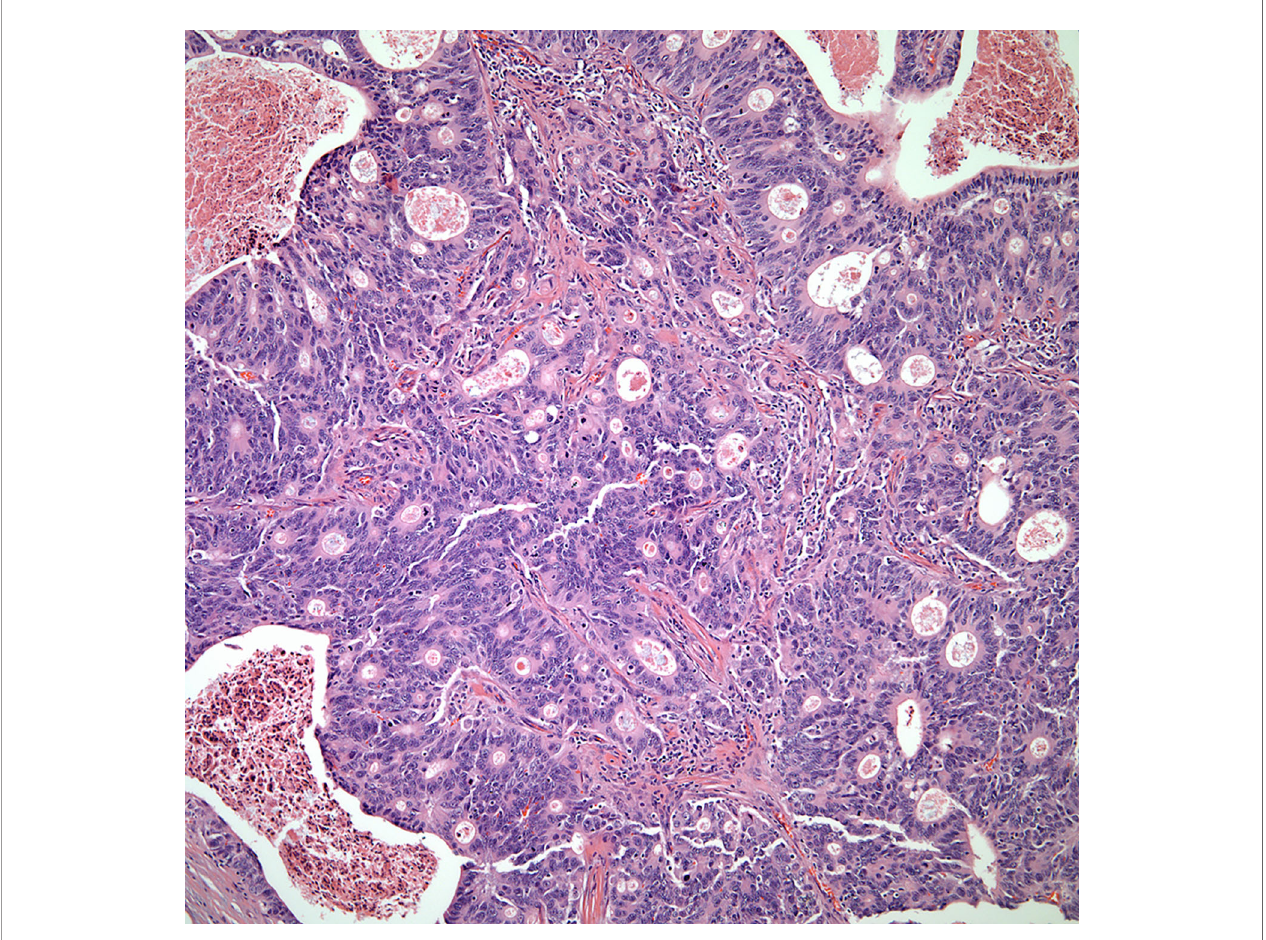
FIGURE 6 | Thymic mucinous adenocarcinoma with “ colonic ”